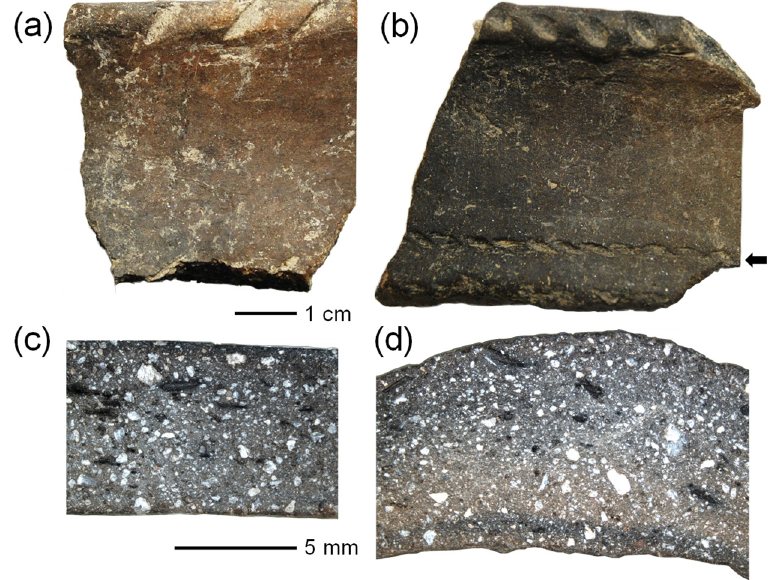
Figure 3. ( a ) Local EBA2 pottery and ( b ) pottery with cord-impressed decoration (arrow). Scale bars are 1 cm. Cross sections of local EBA2 pottery ( c ) and pottery with cord-impressed decoration ( d ). White grains are mineral grains and rock fragments. Black elongated portions are pores. Scale bars are 5 mm.